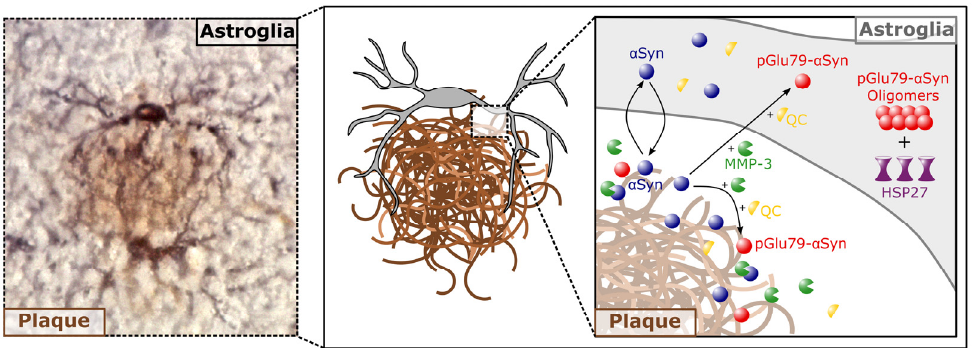
Figure 7 . Combined immunohistochemical and schematic representation of the cellular localization of proteins investigated . ( Left ): Immunohistochemical visualization of astrocytes (GFAP, black) decorating an amyloid plaque (4G8, brown). ( Middle ): Schematic reduction of the immunohistochemical labeling. ( Right ): Zoom into the plaque, plaque periphery and astroglial interior, showing the localization of the proteins investigated in this study (aSyn, blue; pGlu79-aSyn, red; MMP-3, green; QC, yellow; HSP27, violet).